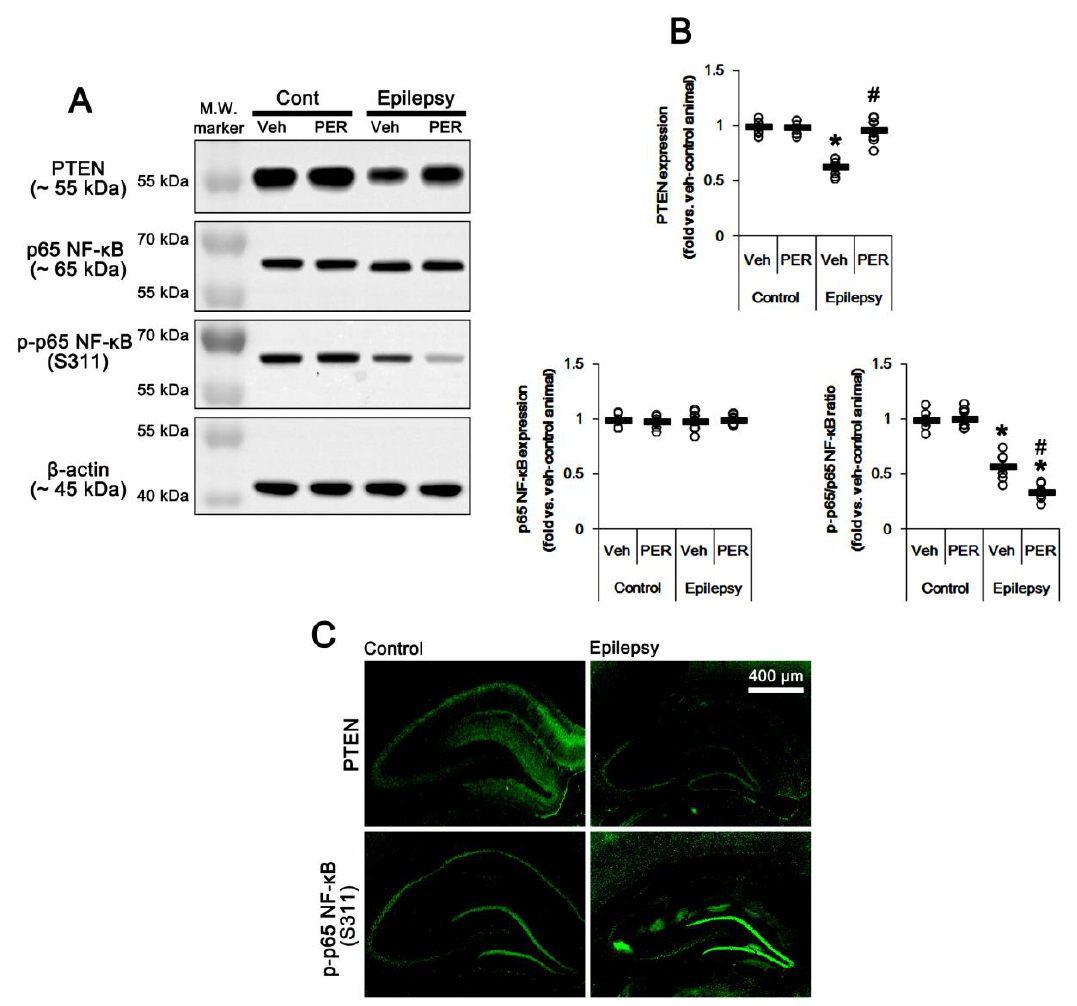
Figure 5. The e ff ect of perampanel (PER) on phosphatase and tensin homolog deleted on chromosome 10 (PTEN) and p65 nuclear factor-kappa B (NF- κ B) expression / phosphorylation in control (cont) and epileptic rats. ( A ) Representative images for Western blot of PTEN, p65 NF- κ B, and p-p65 NF- κ B level in the hippocampal tissues. ( B ) Quantifications of PTEN, p65 NF- κ B, and p-p65 NF- κ B level in the hippocampal tissues. Open circles indicate each individual value. Horizontal bars indicate mean value. Error bars indicate SEM (*, # p < 0.05 vs. vehicle (Veh)-treated control animal and vehicle-treated animals, respectively; one-way ANOVA with post hoc Bonferroni’s multiple comparison; n = 7, respectively). ( C ) Representative photos of PTEN and p-p65 NF- κ B in the control and epileptic rats.